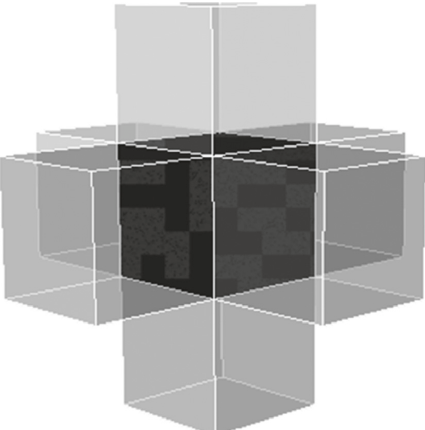
Figure 4: Neighboring cells in the CA model for the corrosion process of high-strength steel wire.